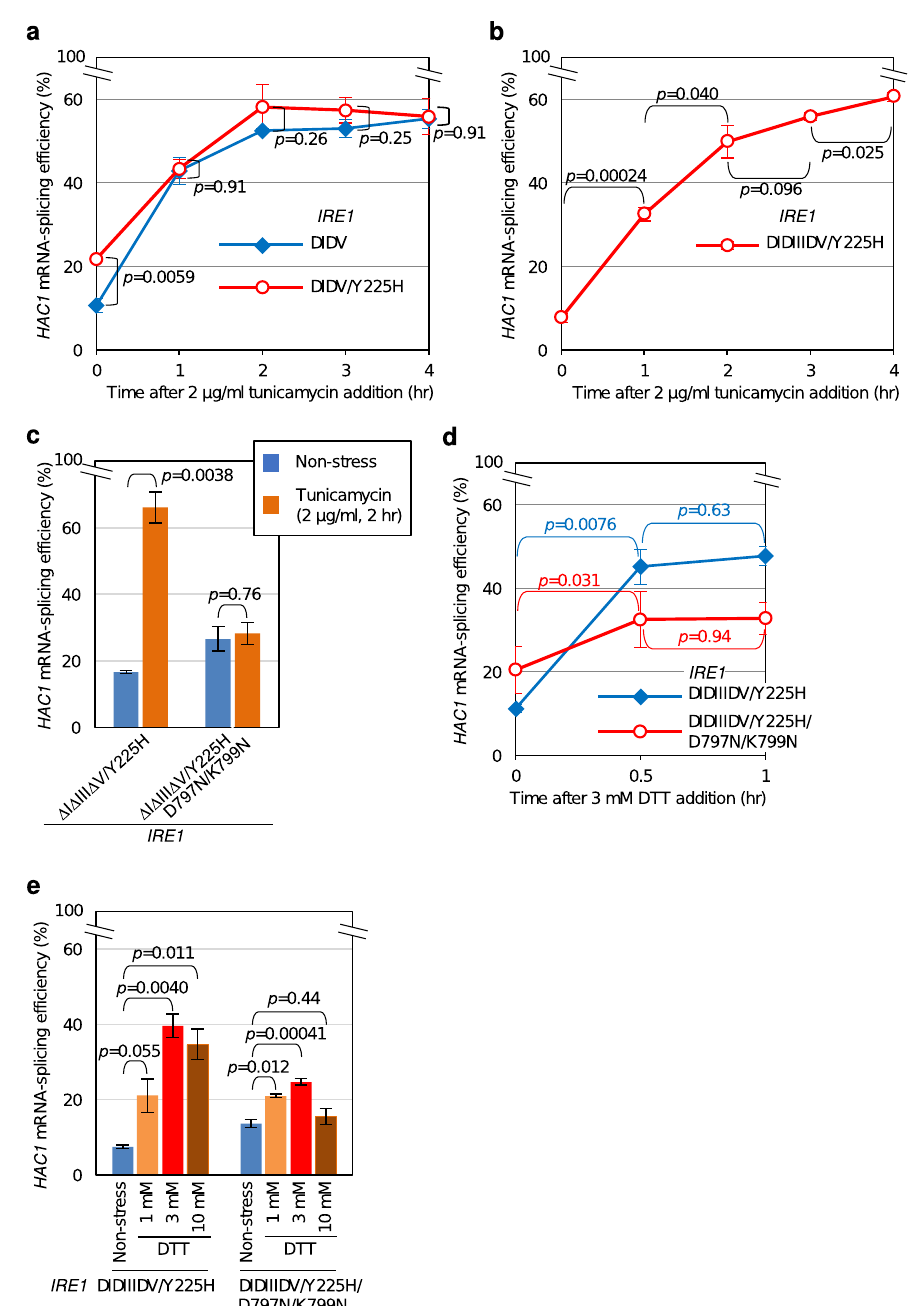
Figure 4. Effect of the D797N/K799N mutation on the ER-stress responsiveness of ΔIΔIIIΔV/Y225H Ire1. After being grown at 30 °C in SD medium, KMY1015 cells ( ire1Δ ) carrying the indicated mutant versions of the IRE1 plasmid pRS313-IRE1 were ER-stressed and checked for HAC1 -mRNA splicing efficiency using the RT-PCR technique. ( a and b ) Cells were cultured in the presence of 2 µg/mL tunicamycin for the indicated durations. ( c ) Cells were cultured in the presence of 2 µg/mL tunicamycin for 2 h or remained unstressed. ( d ) Cells were cultured in the presence of 3 mM DTT for the indicated durations. ( e ) Cells remained unstressed or were cultured in the presence of 1 or 3 mM DTT for 60 min or 10 mM DTT for 30